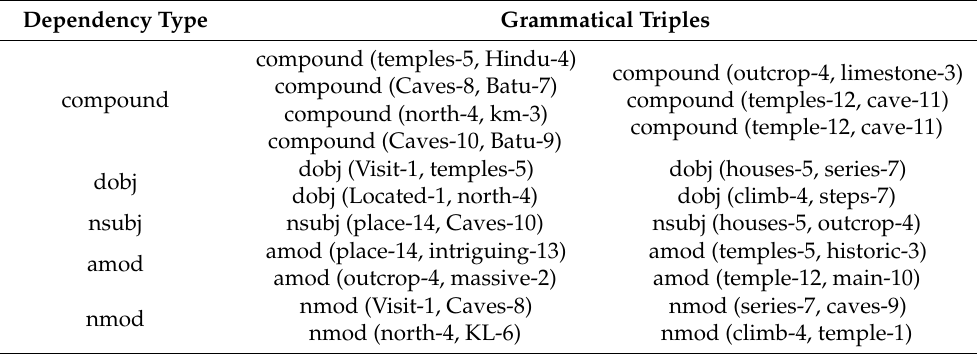
Figure 5. Dependency parsing of the example blog snippet. Table 2. Extracted dependencies list.